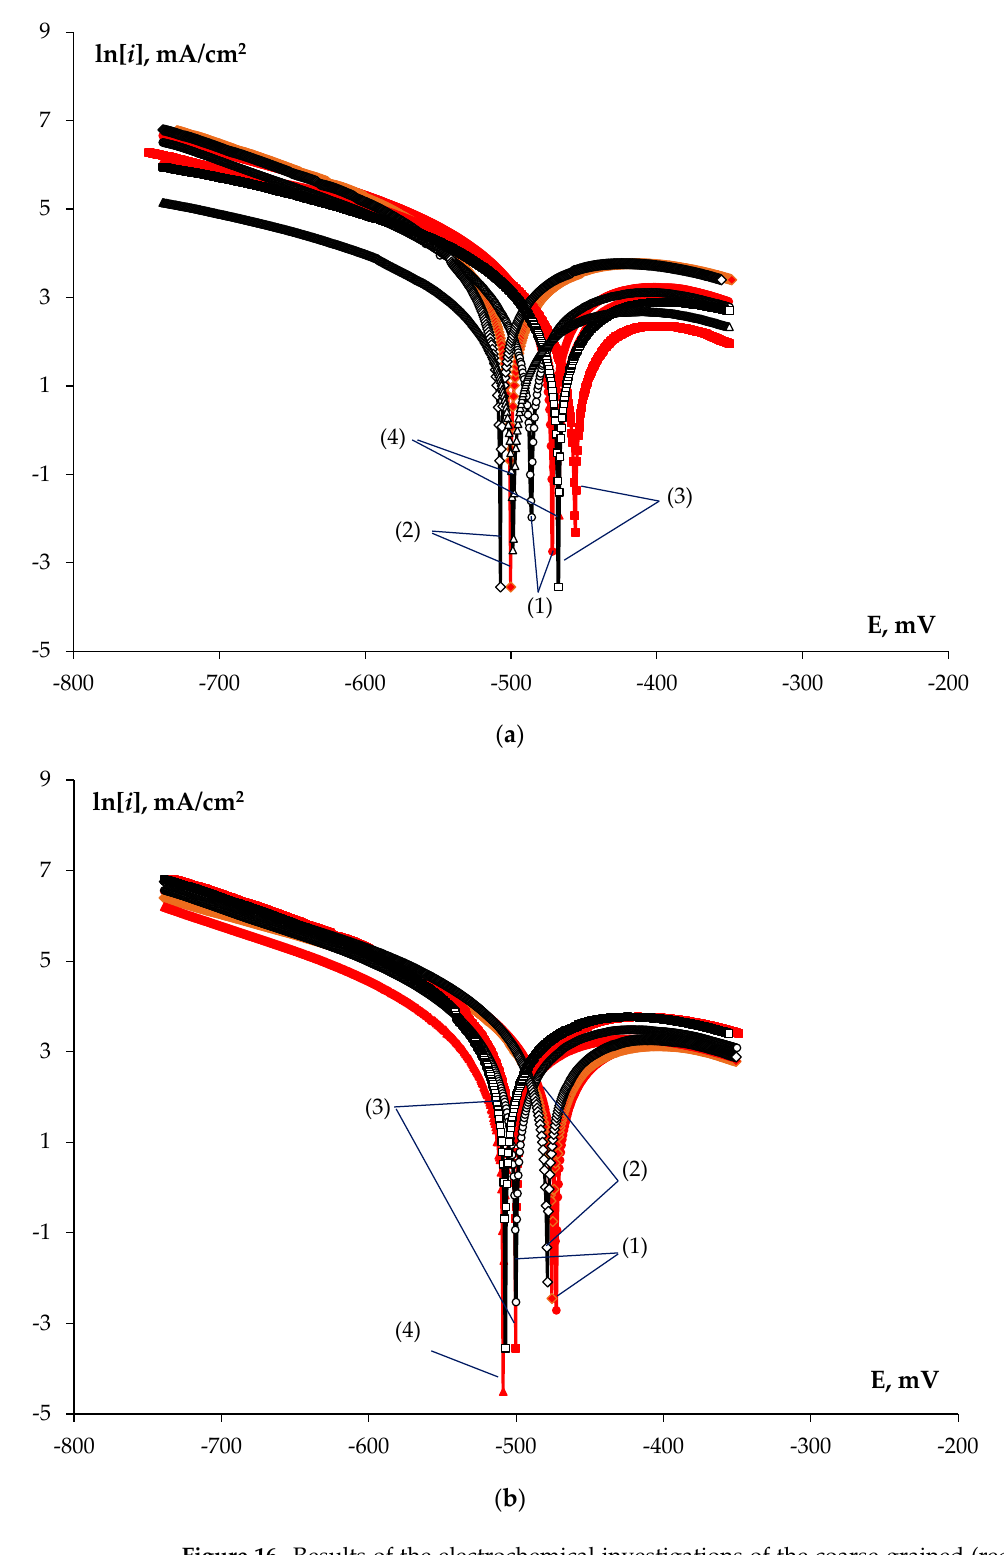
Figure 16. Results of the electrochemical investigations of the coarse-grained (red line) and UFG (black line) specimens: Tafel curves for the ( a ) SPS temperature (circles (line #1)—600 °C, rhombus (#2)—700 °C, squares (#3)—800 °C, triangles (#4)—1030 °C for the coarse-grained alloys; 1140 °C for the UFG alloy); ( b ) heating rate (circles (#1)—10 °C/min, rhombus (#2)—50 °C/min, squares (#3)— 100 °C/min, triangles (#4)—350 °C).